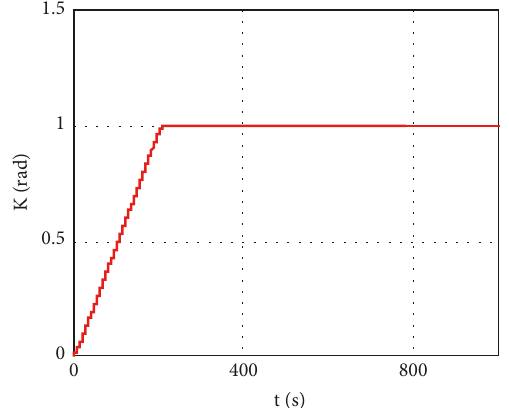
0 Figure 11: Time dependence of the vessel heading angle during accelerated rotation at a given heading angle of 57.3 degrees for values 𝑧 ∗ 3 = 0.05𝑟𝑎𝑑 ⋅ 𝑠 −1 , 𝑧 ∗ 6 = 1𝑟𝑎𝑑 .